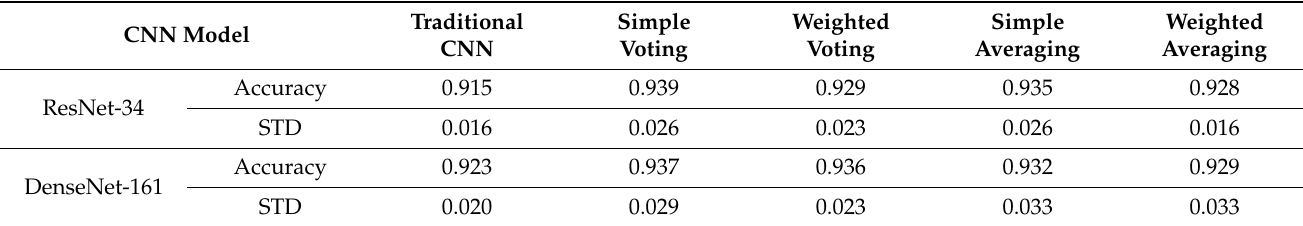
Table 3. Classification accuracy and standard deviation of traditional CNN and FC-CNN combining